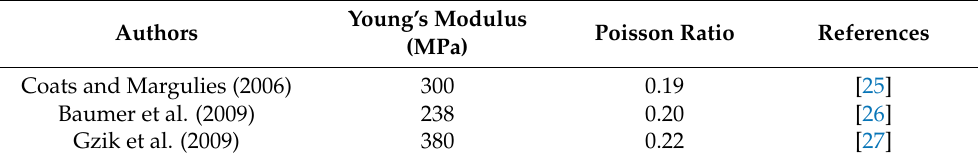
Table 1. Material properties of skull bones were obtained by different authors.